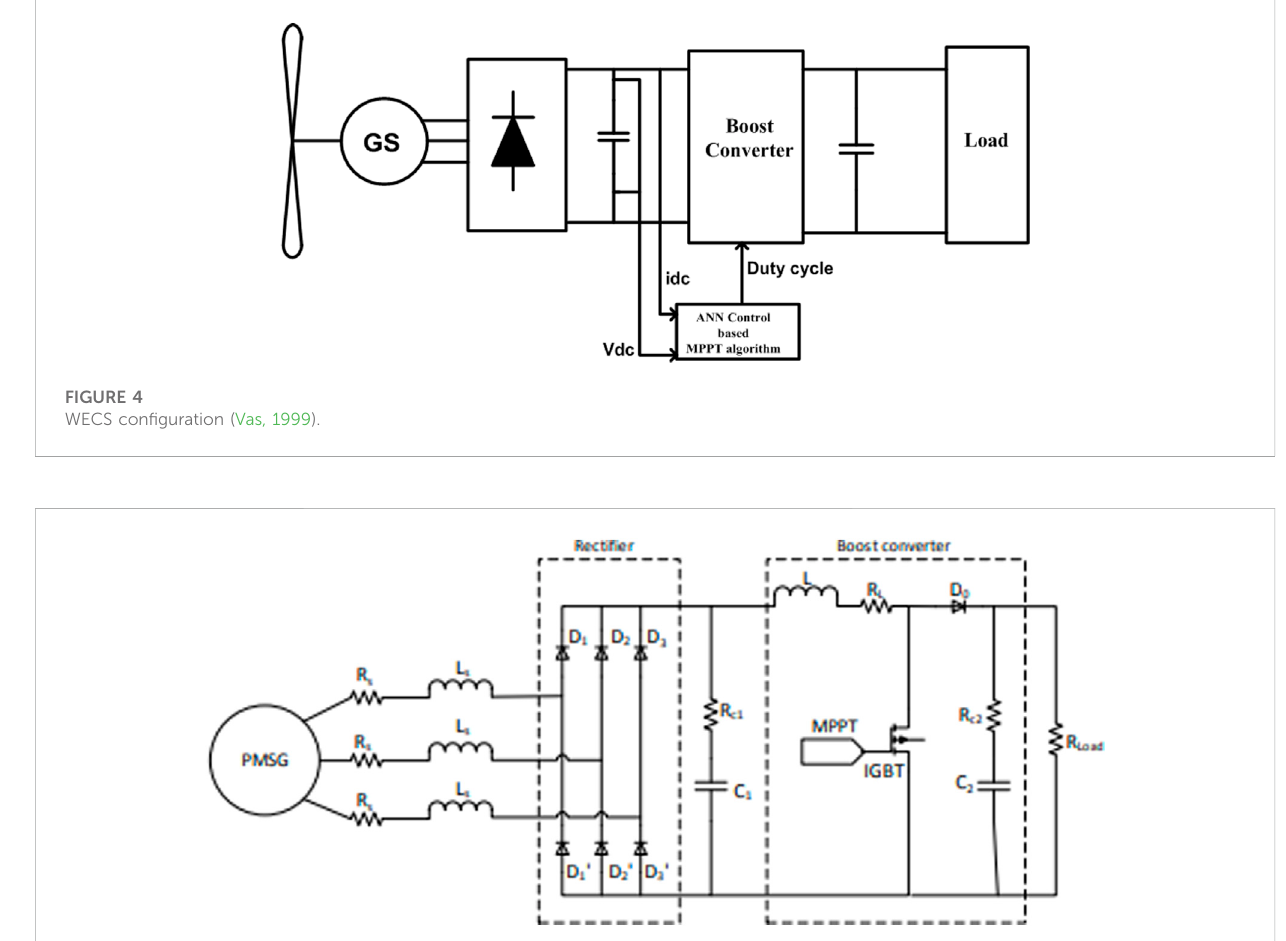
FIGURE 5 Electrical circuit schematic that depicts the PMSG, recti fi er, and boost converter (Mishra and Panigrahi, 2019).